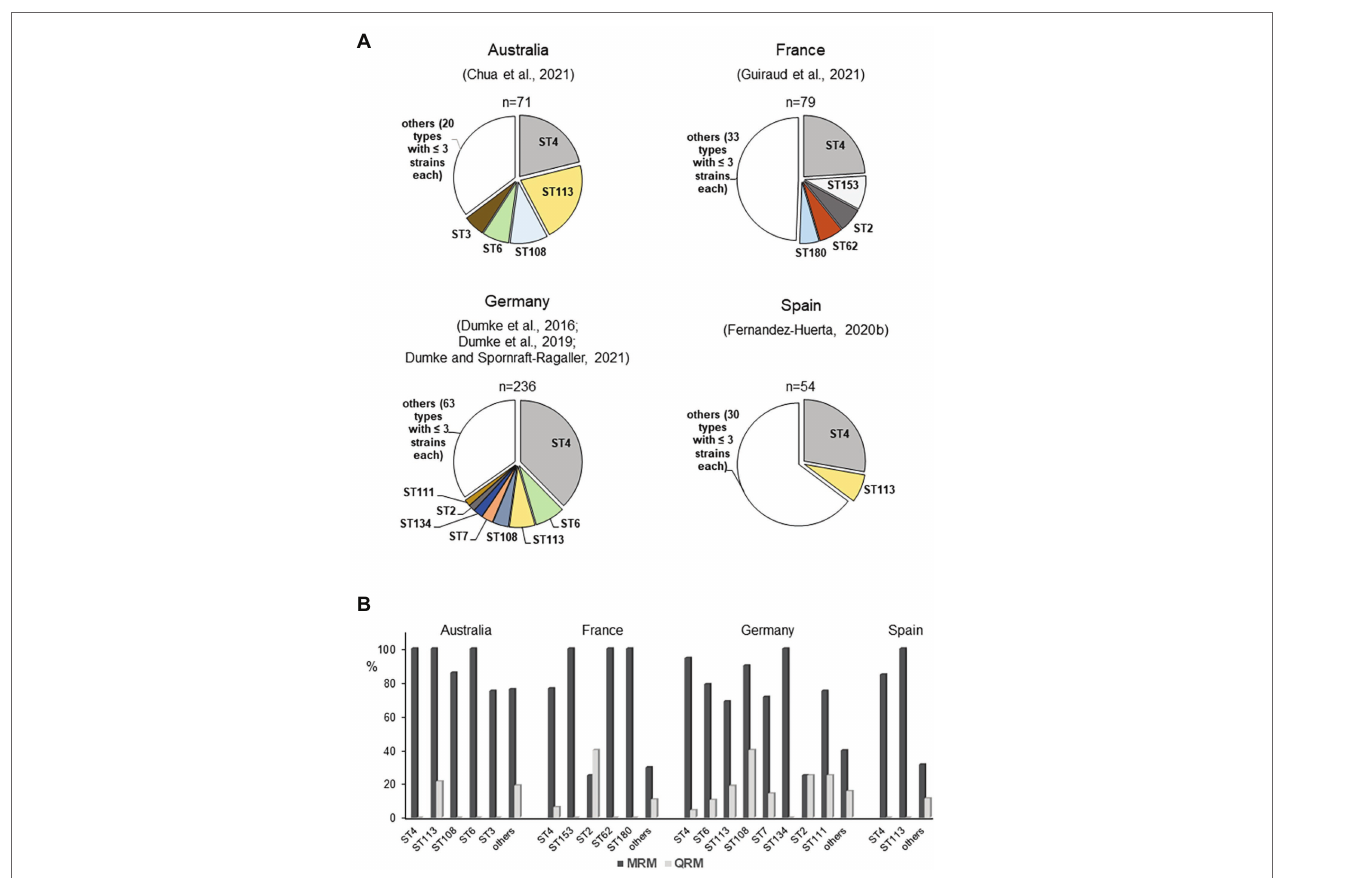
FIGURE 3 | Regional distribution of mgpB types (A) and association between mgpB type and resistance (B) among strains in selected studies included mainly men who have sex with men (MSM; Dumke et al., 2016, 2020; Fernandez-Huerta et al., 2020b; Chua et al., 2021; Dumke and Spornraft-Ragaller, 2021; Guiraud et al., 2021). Strains with S83N change of ParC are not included. ST, mgpB type; MRM, macrolide resistance-associated mutation; and QRM, quinolone resistance-associated